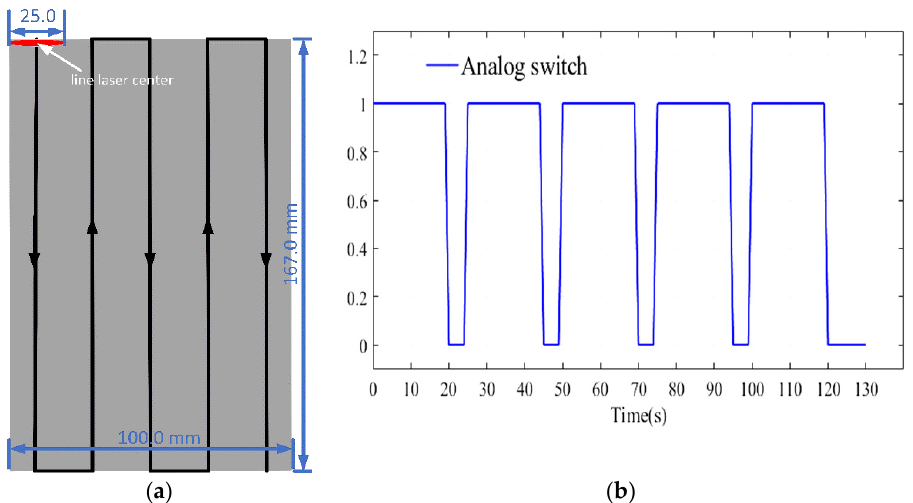
Figure 2. The laser focus moves in a specified way: ( a ) x ‐ axis moving mode of laser and ( b ) focus changes along the z ‐ axis.